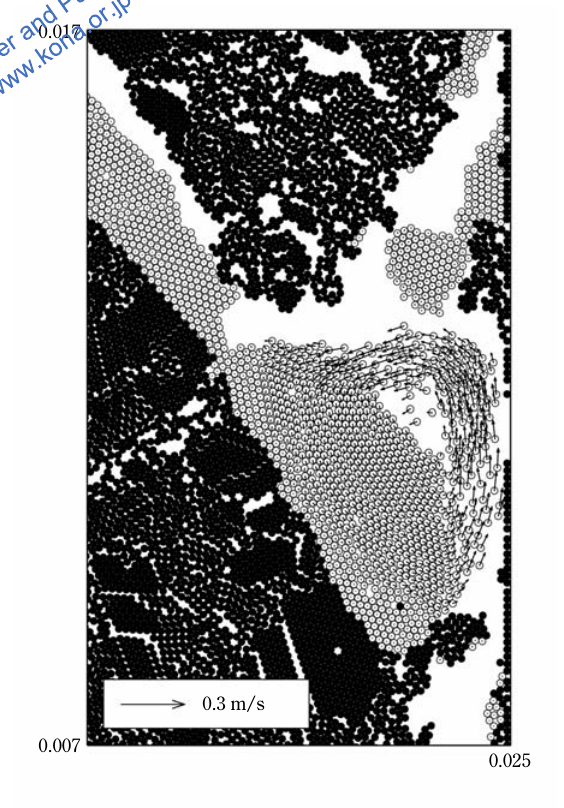
Fig. 2 The localised solids motion in a macroscopically de-flu- idized bed at t (cid:1) 4s and u/u mf (cid:1) 4.8, showing the circulation of cohesionless (white) particles in the gap between blocks of cohesive (black) particles and side wall. The ratio of the maximum cohesive force at z min to particle weight is 338.